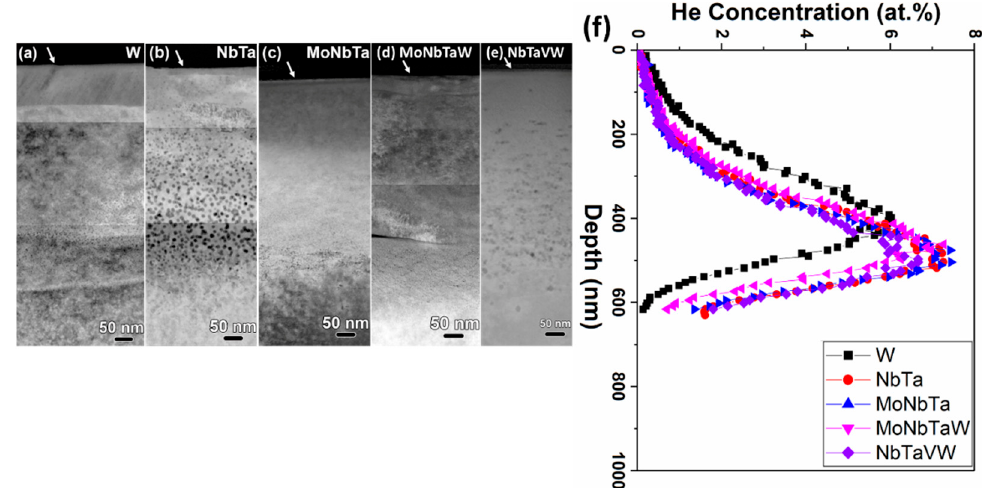
Figure 2. ( a – e ) STEM-HAADF micrographs of irradiated samples showing the He bubbles in the subsurface. Arrows indicate the location of the sample surface. ( f ) SRIM-predicted He implantation profiles in all irradiated samples.